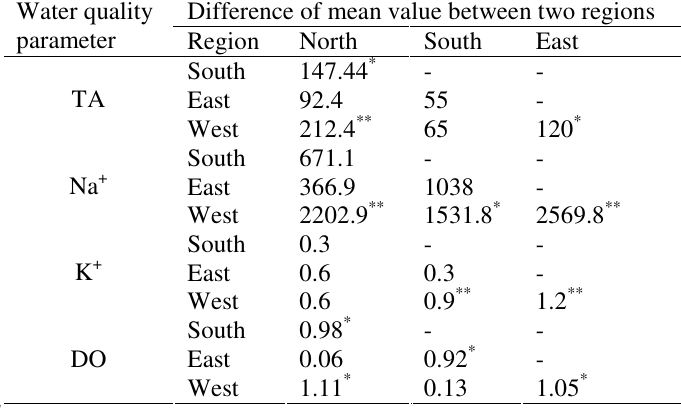
Table 8. Difference of mean values of various quality parameters of ground water among the various region of Gandhinagar